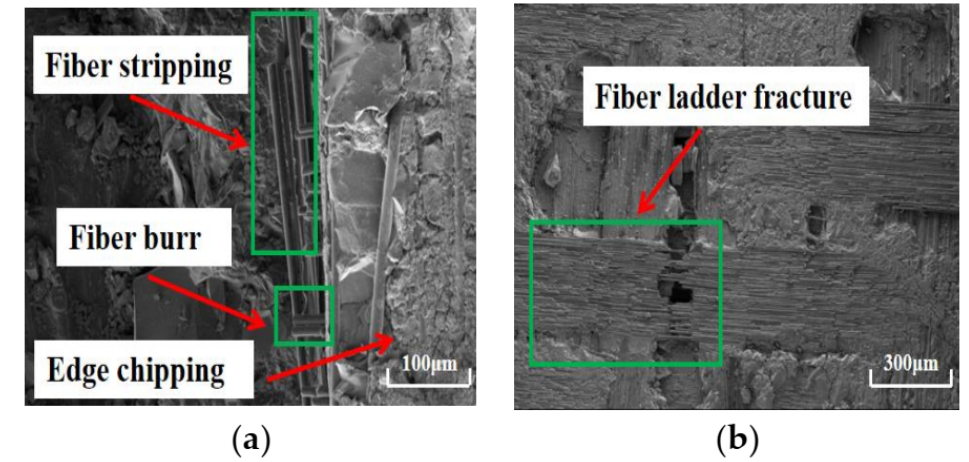
Figure 9. Morphology of the surface machined with CVD diamond tool in dry machining: ( a ) sidewall ( × 180); ( b ) bottom ( × 30).